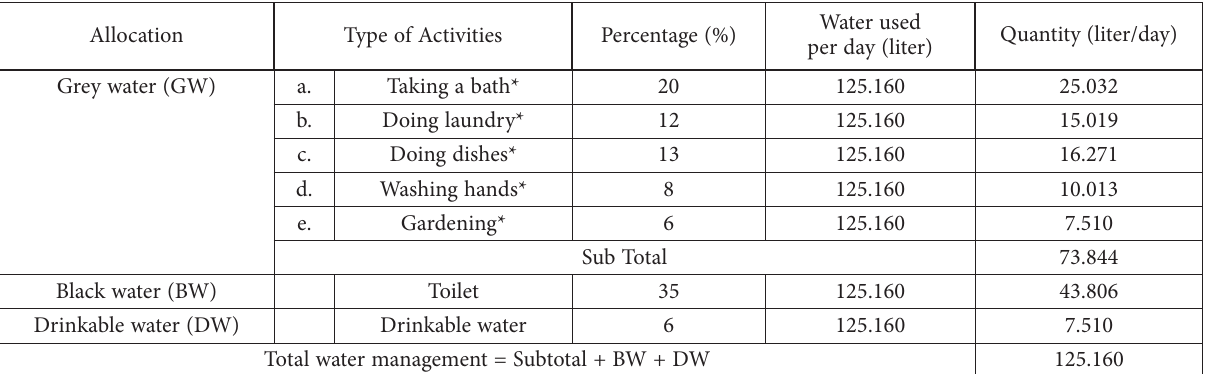
Table 8. Allocation of water per day in Kampong Pakuncen